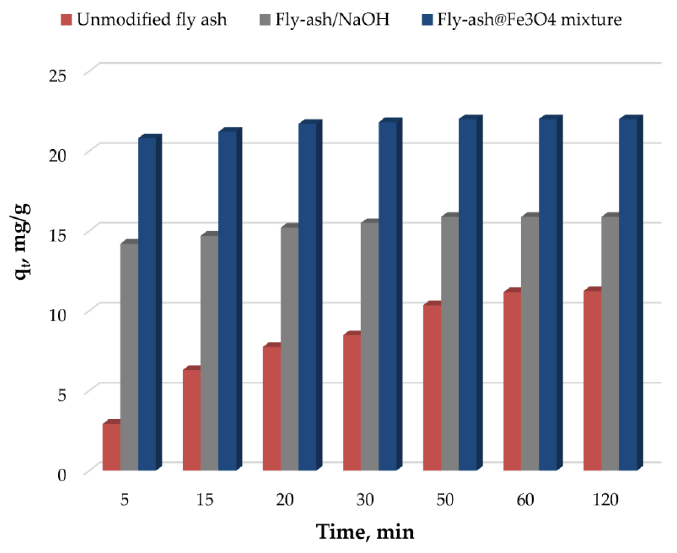
Figure 3. Comparison of unmodified fly ash, Fly-ash/NaOH, and Fly-ash@Fe 3 O 4 adsorbents .